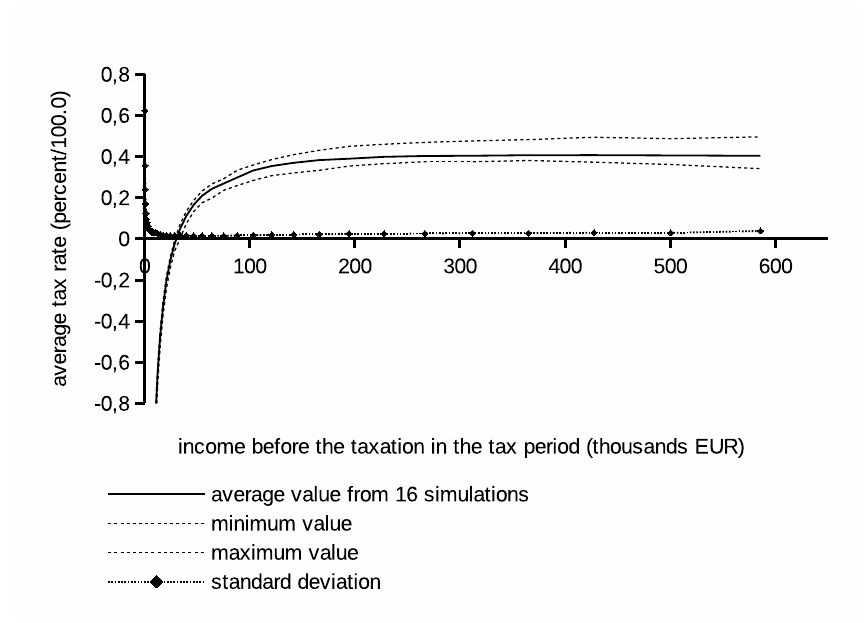
Figure 6. Distribution of average income tax schedules obtained from repeated simulations. Table 4. Aggregates obtained from repeated simulations.